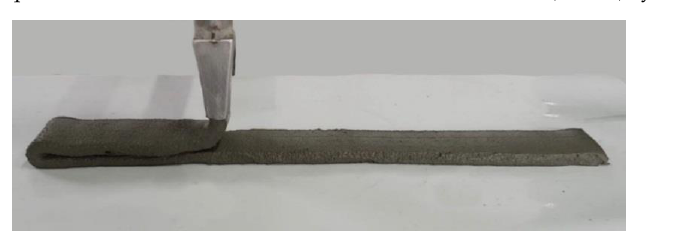
Figure 3. View of 3DAC test.